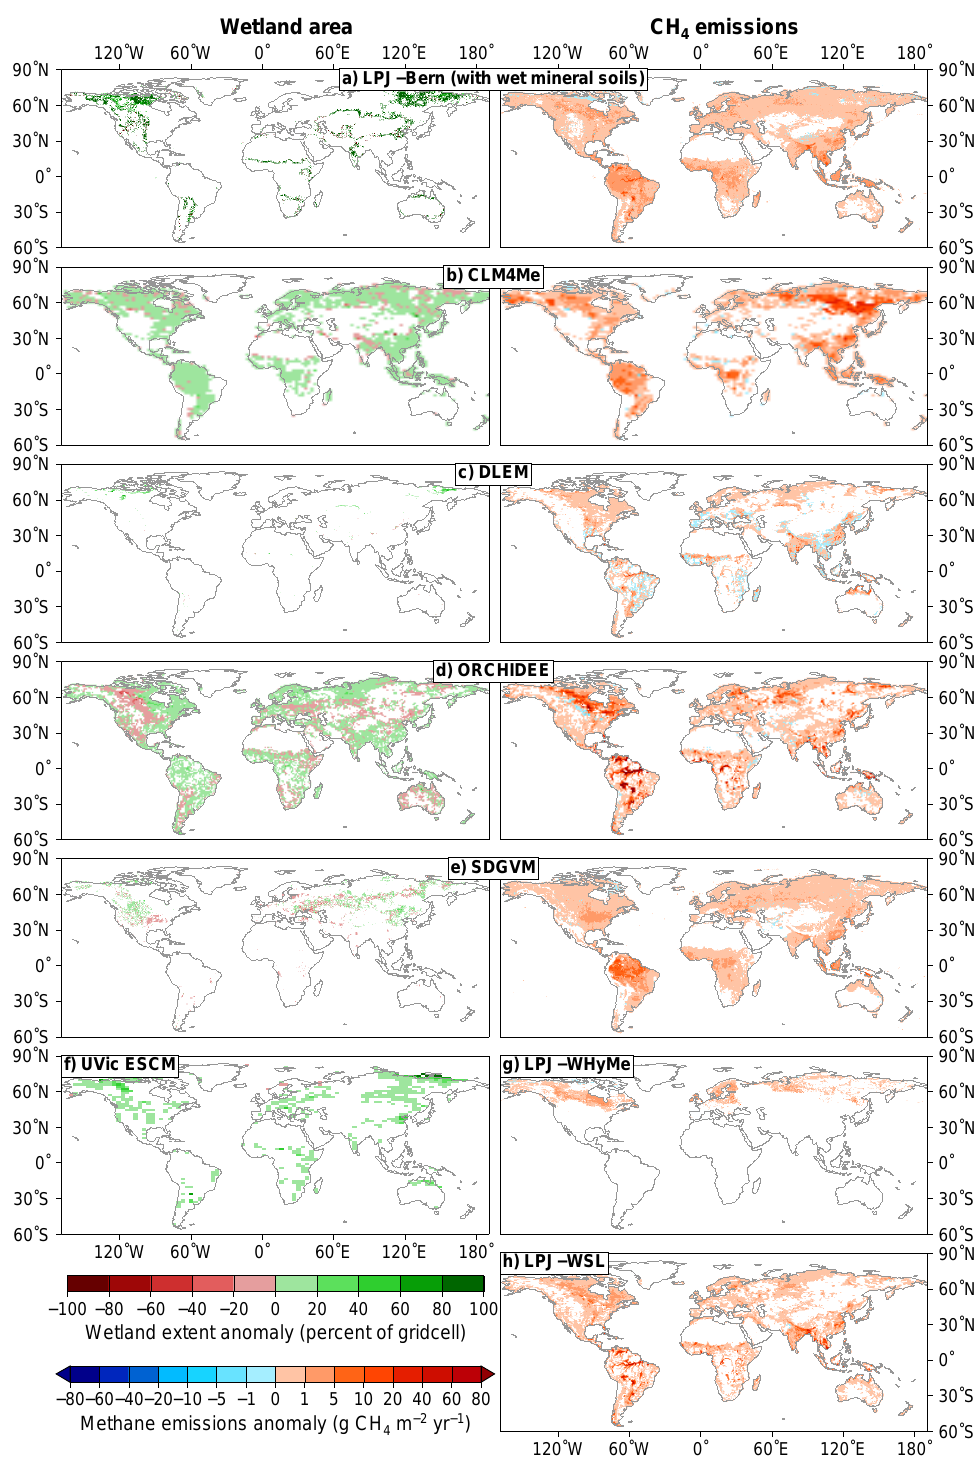
Fig. 8. Model wetland areas and CH 4 flux anomalies from the model state with elevated atmospheric [CO 2 ] (Experiment 4) compared to the equilibrium simulation (Experiment 1). Methane flux anomalies are referenced to grid cell m 2